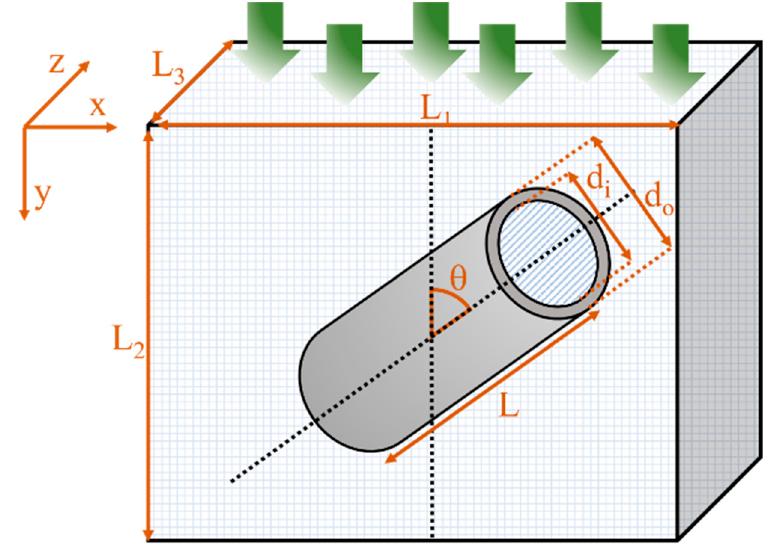
Figure 2. Schematic diagram of a repetitive unit element of a mixed-matrix membrane.